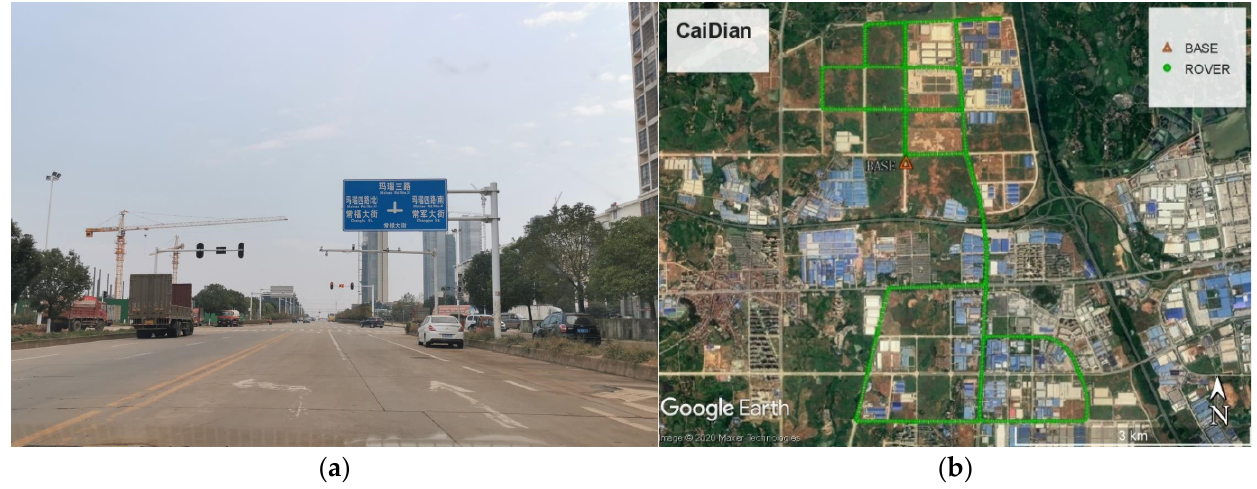
Figure 12. Kinematic vehicle experiment in the open urban environment: ( a ) test scene; ( b ) test trajectory.